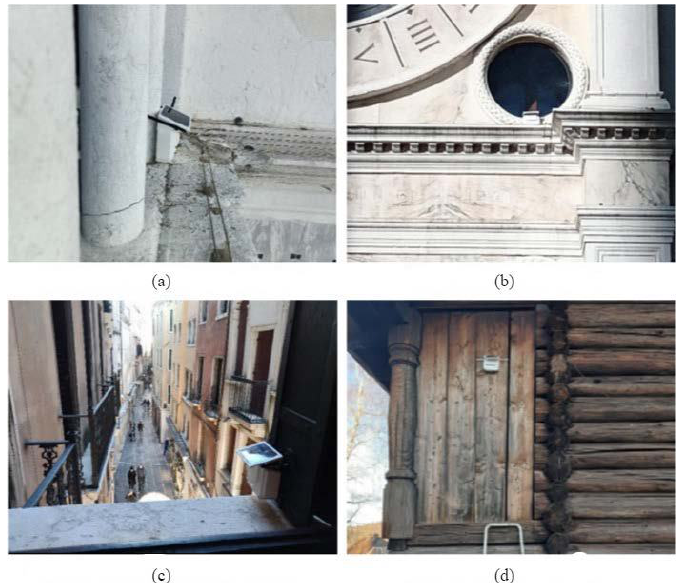
Figure 10. Smart Tags deployment on each CH site: ( a ) Saint Nicola Lighthouse— Rhodes, ( b ) Torred’Orologio—Venice, ( c ) San Jeronimo Monastery—Granada and ( d ) Heierstad Loft—Tonsberg.